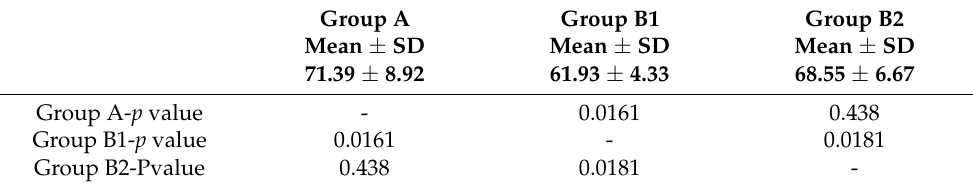
Table 2. Mean and standard deviation of RFA values in paired comparison for all three